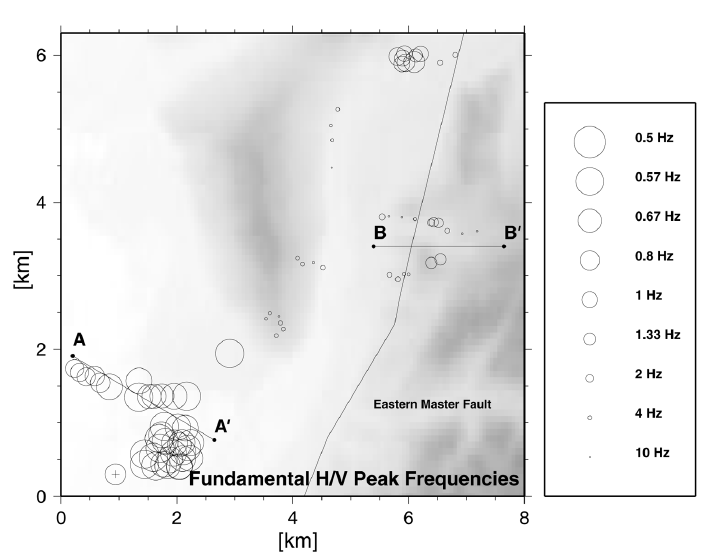
Fig. 3. Fundamental peak H / V frequencies found in the study area, location of profile A-A ′ and B-B ′ (see fig. 4) and the position of the eastern masterfault of the Rhine Rift Valley. The cross indicates the location of the deep drillsite in